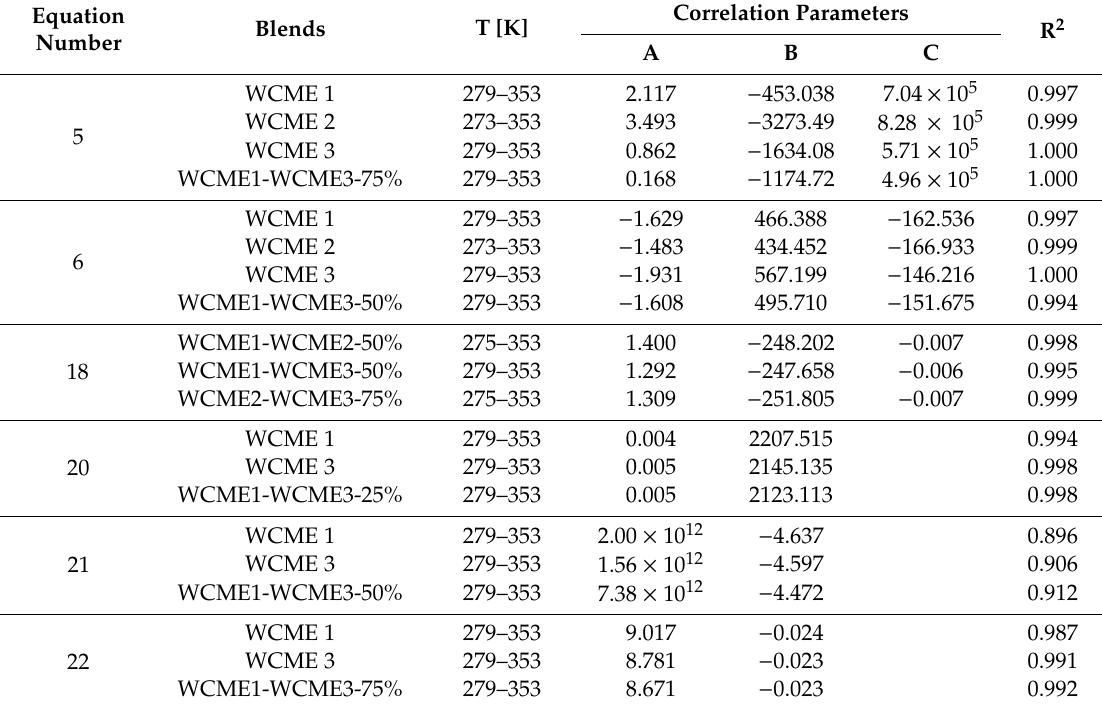
Table8. Kinematicviscosity-temperaturecorrelationsfordifferentbiodieselblends; correlationparameters and R 2 .